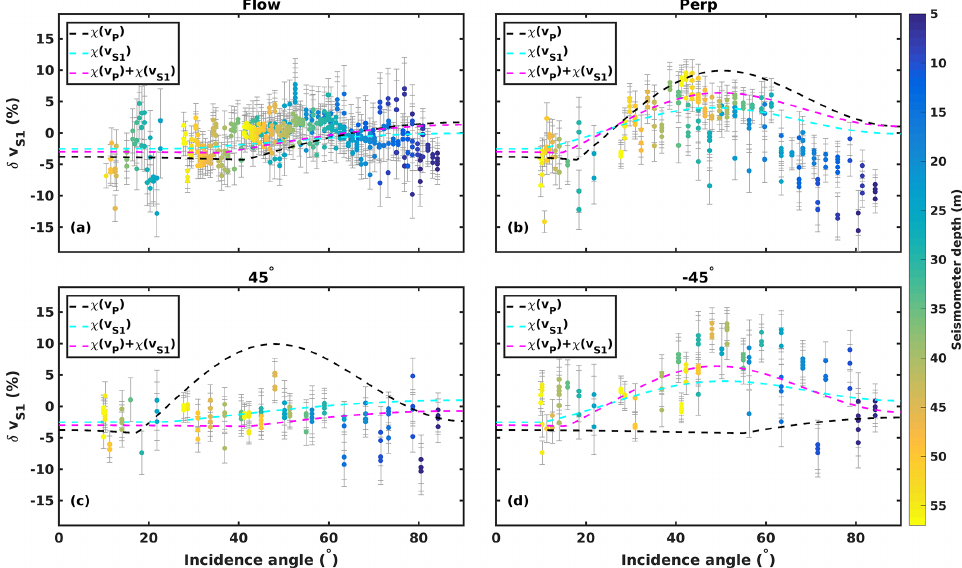
Figure 9. Multi-azimuth S-wave observed velocity anisotropy (symbols) and model results (dashed lines) along the different profiles. Symbol colour shows sensor depths. (a) Flow profile; (b) Perp profile; (c) 45 ◦ profile; (d) − 45 ◦